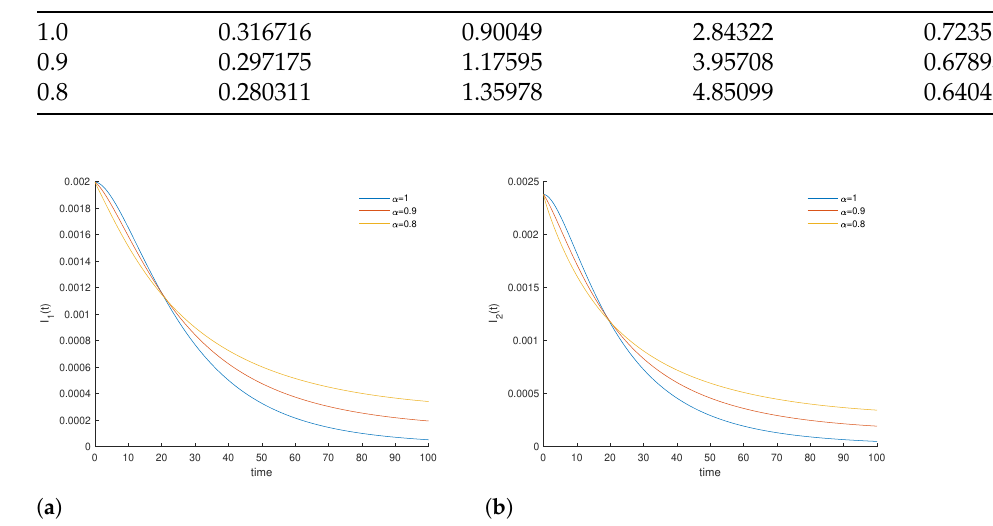
Figure 5. Variables I 1 and I 2 of the FOCP (8)–(13) with values from Table 1 and fractional order derivatives α = 1.0, 0.9 and 0.8. ( a ) Evolution of infected individuals of 1st community; ( b ) Evolution of infected individuals of 2nd community.